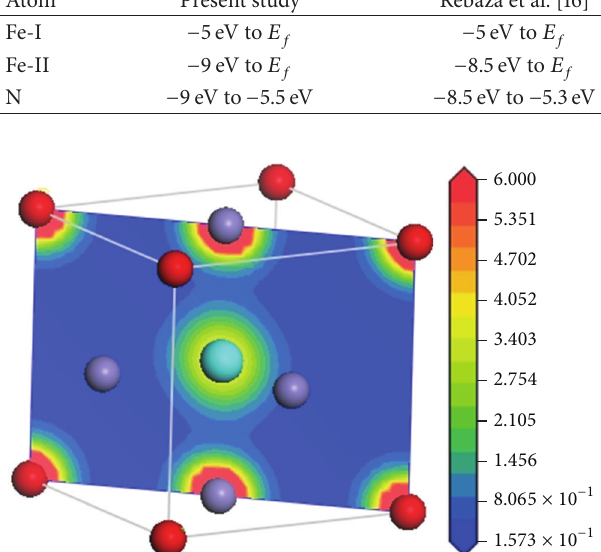
Figure 3: Total electron density map on the tridiagonal plane with Fe-I and N atoms at 𝑎 = 3.772 ˚A.